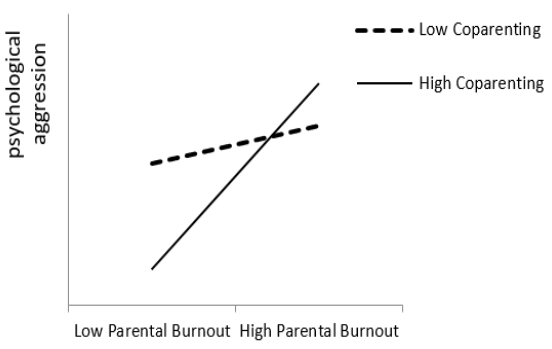
Figure 6. The moderating effect of co-parenting on parental burnout and psychological aggression.